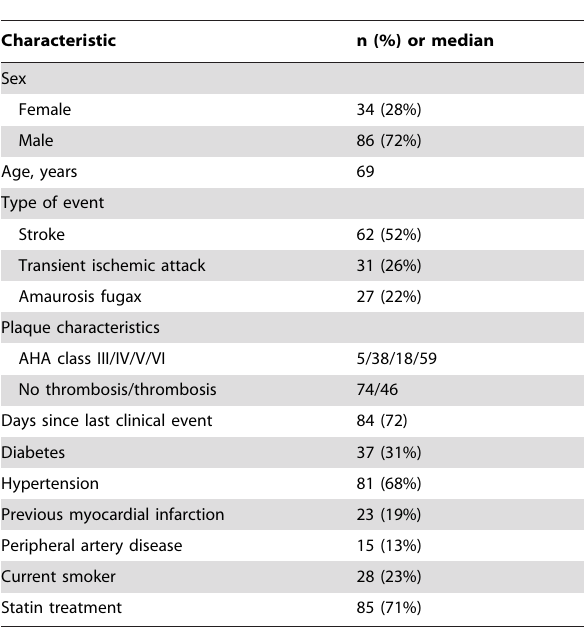
Table 1. Patient and plaque characteristics